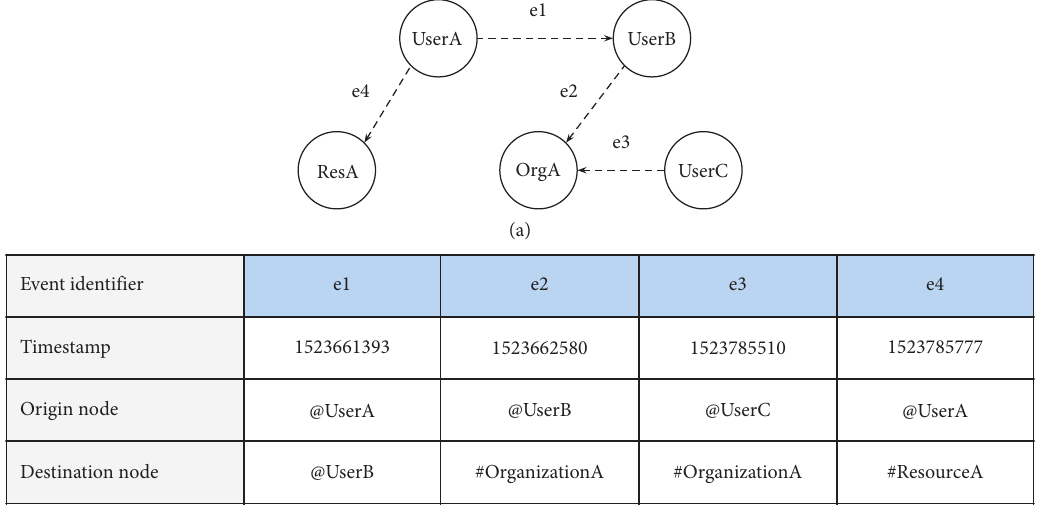
t ) of a multimodal organizational